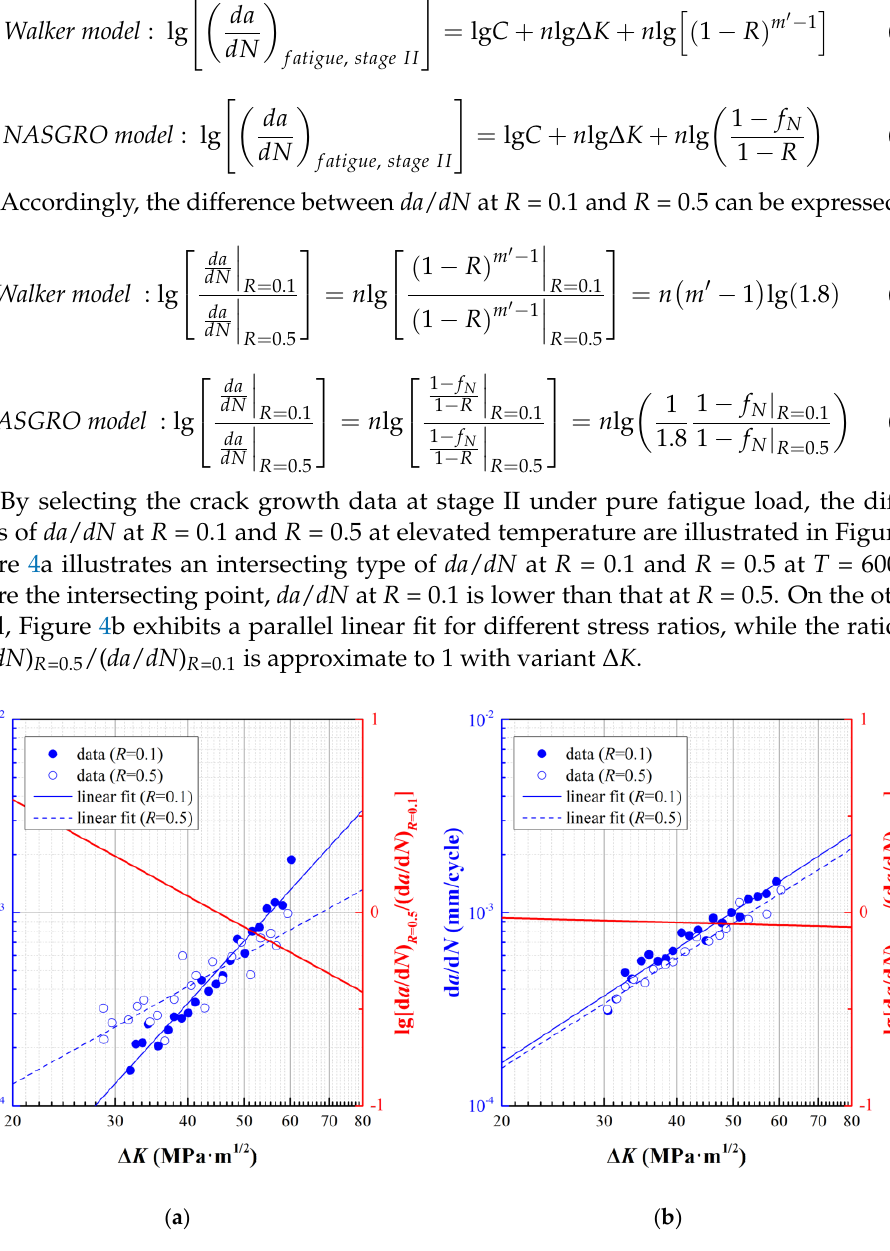
Figure 4. Experimental data and fitting results for fatigue crack growth at stage II. ( a ) T = 600 °C; ( b ) T = 700 °C.